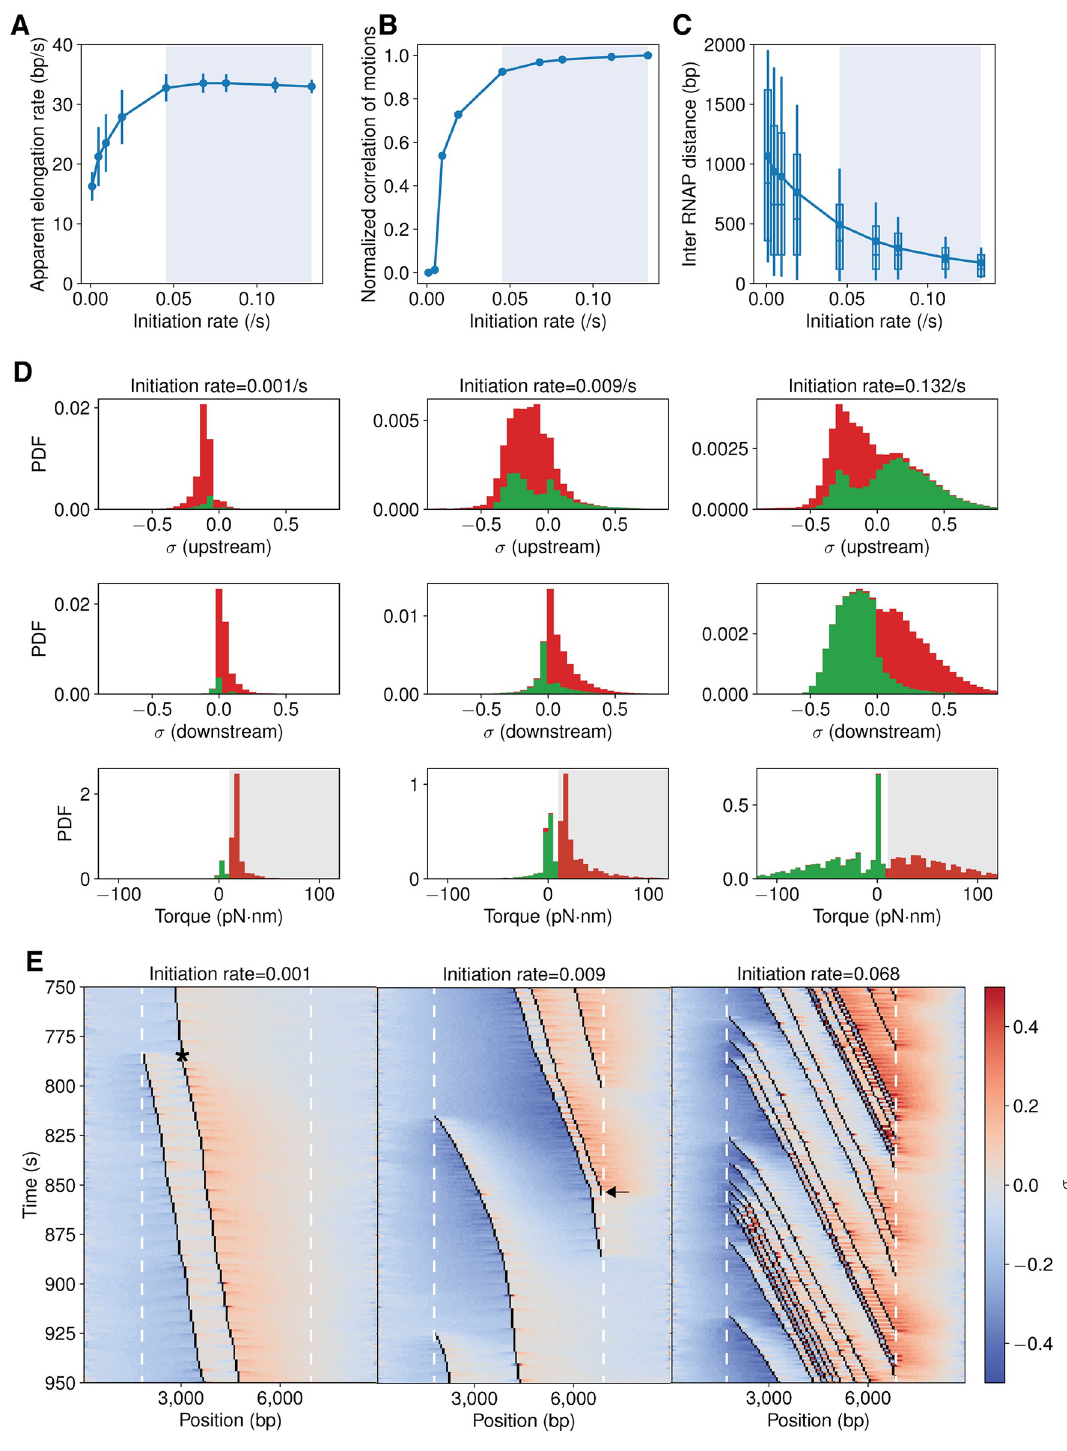
Fig 2. Cooperation of RNAP transcription is favored by high initiation rates and antagonized by low initiation rates. (A) The apparent RNAP elongation rate increases and reaches maxima (blue shaded region) as the initiation rate increases. Error bars are standard deviations from 1000 simulations. (B) Pearson correlation coefficient of adjacent RNAP trajectories increases and approaches unity (blue shaded region) as the initiation rate increases. The correlation coefficient is normalized such that “0” corresponds to the case of independently transcribing RNAP trajectories and “1” corresponds to the case of the co-transcribing RNAP trajectories in the highest